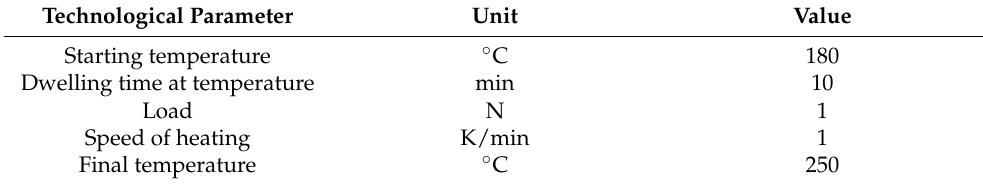
Table 3. Parameters of TMA measurements.